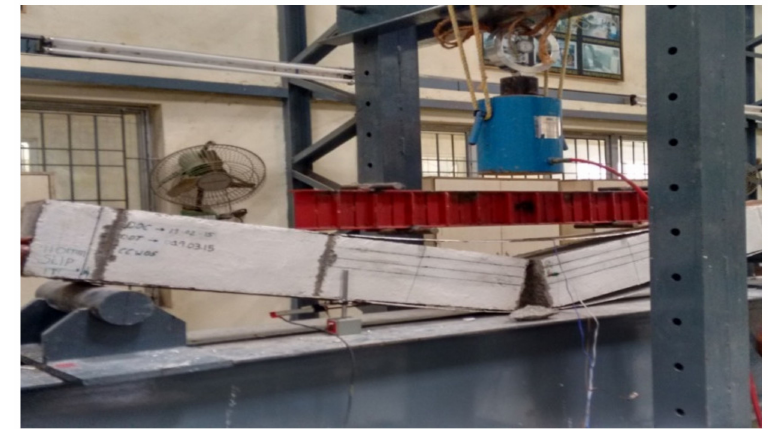
Figure 11. Specimen failed at flexural zone.